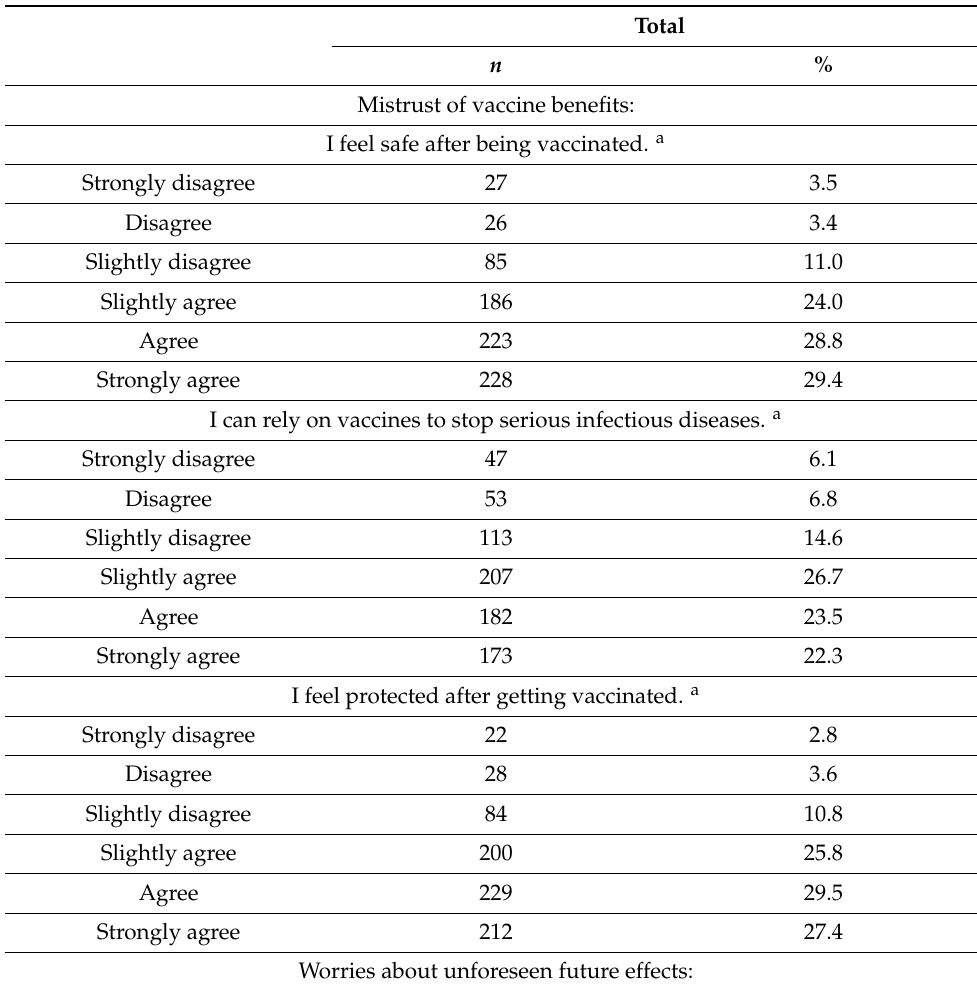
Table 6. Four domains of negative attitudes towards the vaccination programme. a Items were reverse